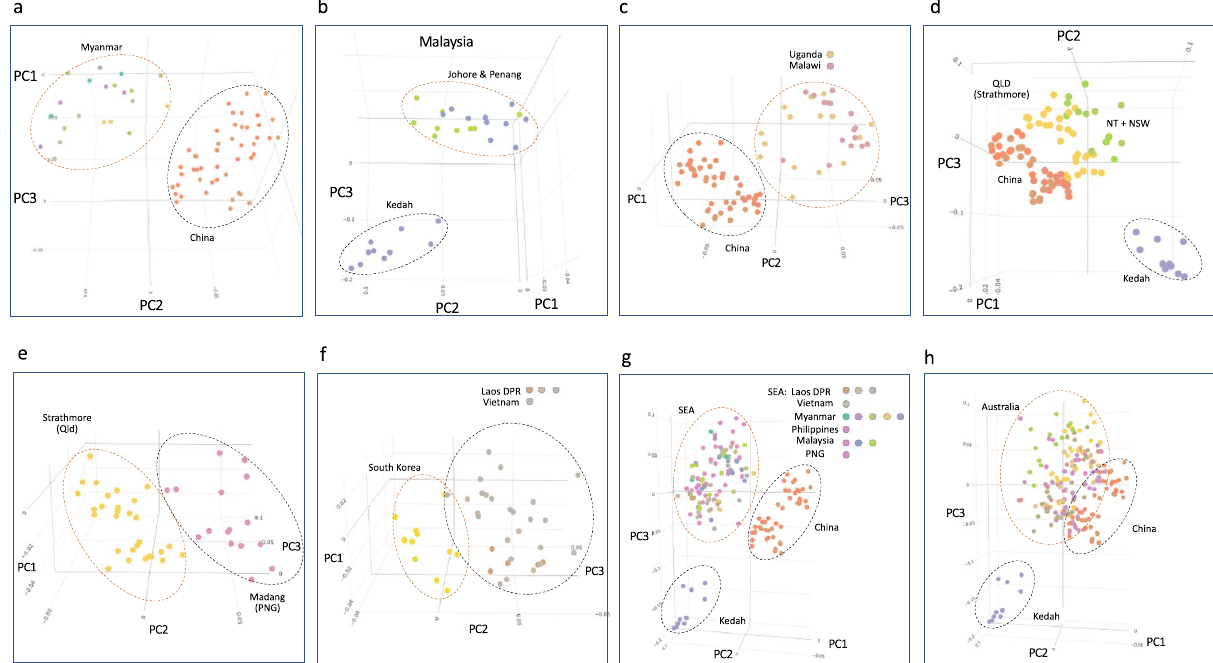
Figure 3. Principal component analysis (PCA) showing variability between selected FAW populations from their invasive ranges. ( a ) China and Myanmar; ( b ) Kedah and Johor/Penang populations from Malaysia, (c) China and east African (Uganda/Malawi) populations, ( d ) Australia (Strathmore, Qld/Northern Territory + New South Wales), China, and Malaysia (Kedah) populations, ( e ) Australia (Strathmore, Qld) and PNG (Madang Province) populations, ( f ) Lao PDR/Vietnam and South Korea populations, ( g ) China and SE Asian (Lao PDR/ Vietnam/Myanmar/Philippines/Malaysia) and Pacific/Australia (PNG) populations, and ( h ) Australia, China and Malaysia (Kedah) populations. Note the overall population genomic variability between countries (e.g., a , c – g ) and within countries (e.g., Malaysia ( b ), Australia ( d )). Populations with similar genomic variability are also evident, e.g., for Strathmore ( e ) and South Korea ( f ); and for Madang ( e ) and Lao PDR/Vietnam ( f ), further supporting potential different population origins of various FAW populations across the current invasive regions. The Southeast Asian and Chinese populations are overall different ( g ), Australia’s FAW populations showed similarity with both Southeast Asia and China ( g , h